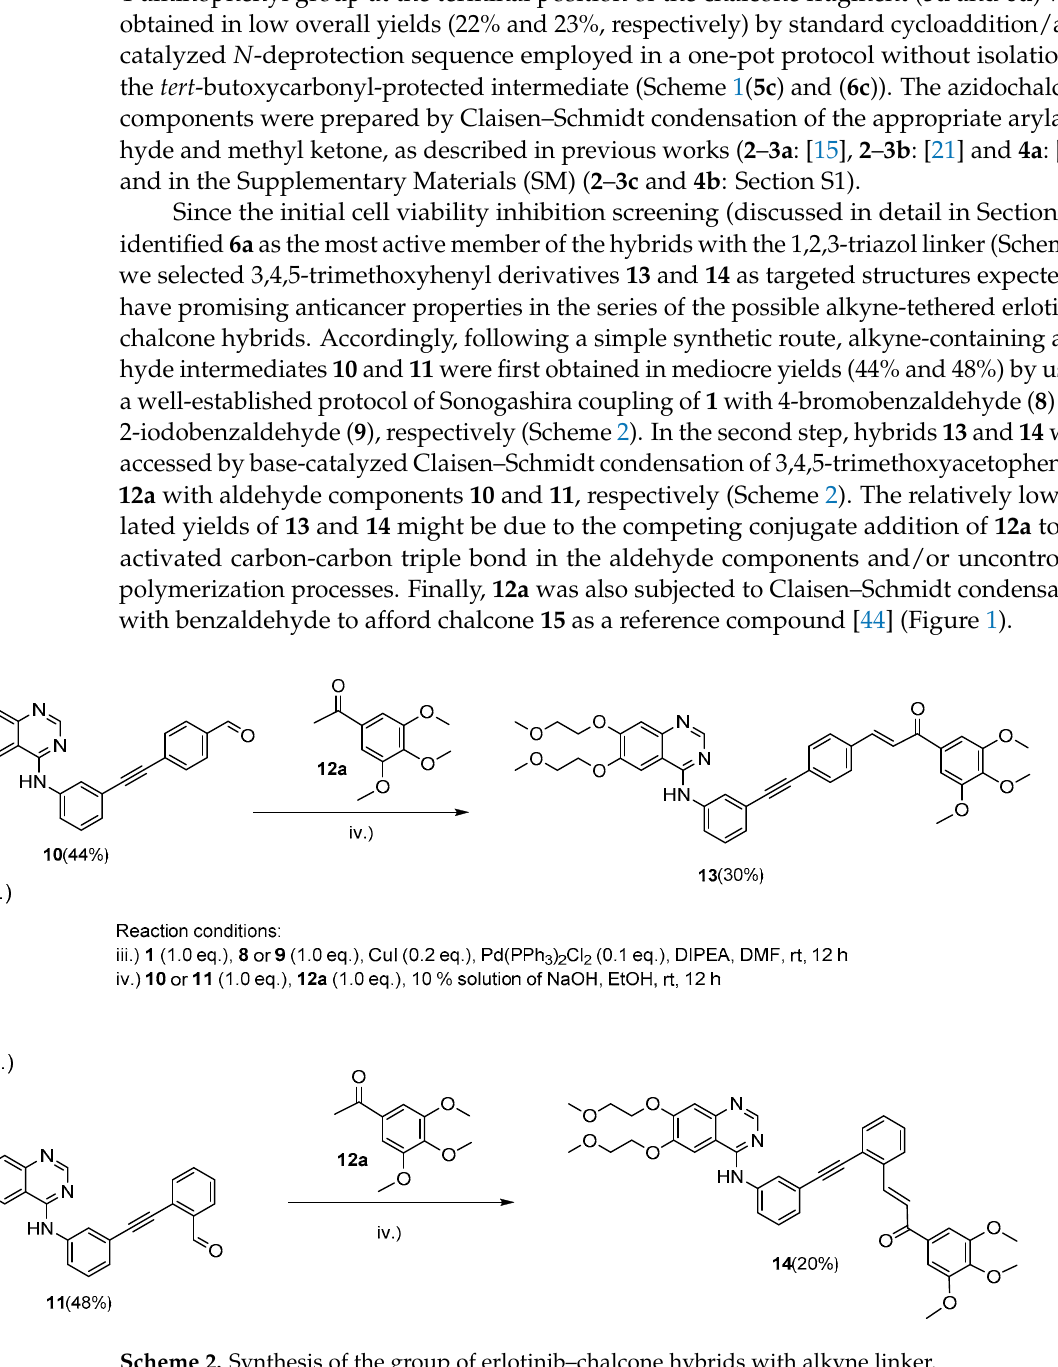
Figure 1. The novel hybrids emerged as the most potent model compounds in the viability assays ( 6a , 13 and 14 ), which were selected for further biological studies (red) using erlotinib ( 1 ) and chalcone ( 15 ) as reference fragments (blue) exploited in structure design. 2.2. In Vitro Cell Viability Inhibition Screening of Novel Erlotinib–Chalcone Hybrid Molecules on HNSCC Cell Lines The synthesized compounds were screened for their anticancer activities against three HNSCC cell lines (Fadu, Detroit 562 and SCC-25) using the CellTiter-Glo lumines- cent cell viability assay (Figure 2). The screening was performed at a 10 μ M concentration and 72 h treatment time, and untreated cells (cultured in 0.2% DMSO-containing medi- um) were used as reference. The efficacy of the compounds that constitute the two fun- damental moieties of our molecular hybrids, i.e., 1 and 15, were also assessed. Although 3a , 5b , 6d and 15 were also found to be more potent antiproliferative agents than 1 , among the tested hybrid molecules, 6a, 13 and 14 showed the highest efficacy (Figures 1 and 2). These compounds proved to be significantly more potent than either 1 or 15 and were selected for further investigation.